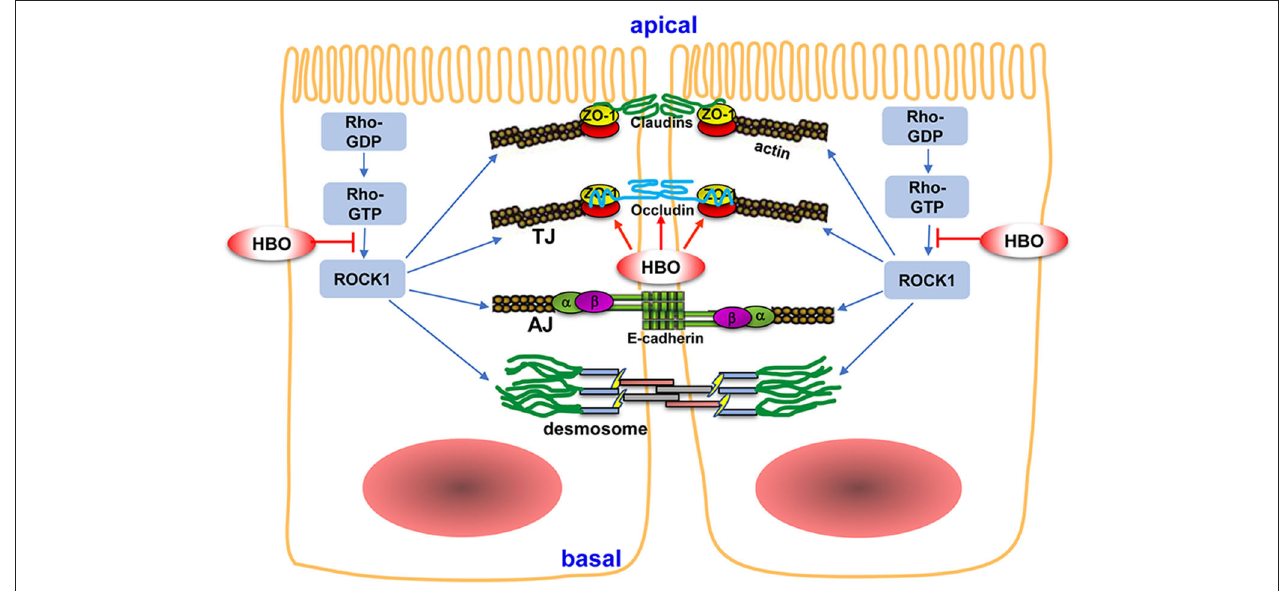
FIGURE 9 | The potential mechanism of HBO treatment on intestinal barrier after SCI. The intestinal mechanical barrier mainly consisted of intact intestinal epithelial cells and their close connections. The connections between adjacent epithelial cells include tight junctions (TJs), adherent junctions (AJs), and desmosomes. TJs are mainly composed of claudins, occludin, and ZO. TJs are regulated by Rho/ROCK signaling pathway. HBO treatment increased the expression of occludin and ZO-1 following SCI and improved intestinal barrier integrity. Furthermore, HBO treatment significantly inhibited Rho/ROCK signaling pathway, which may be the mechanism of HBO treatment on regulating TJ proteins. Arrows indicate activation and lines with bars inhibition. For details, see text. HBO, hyperbaric oxygen; SCI, spinal cord